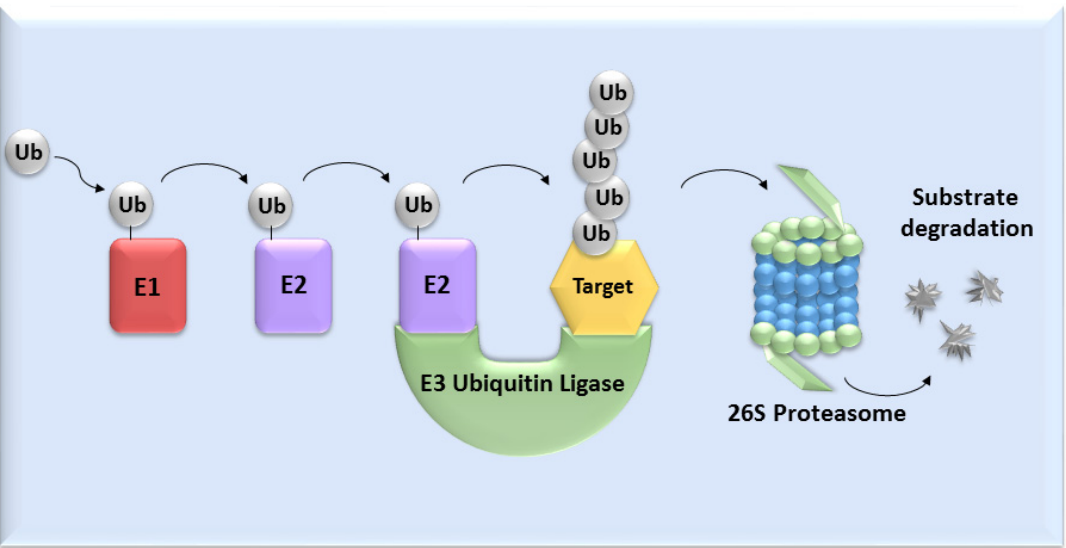
Figure 1. The ubiquitin-proteasome system. Activation and binding of ubiquitin to the target substrate is mediated by three enzymatic complexes (E1, E2 and E3 enzyme). The substrate is selected by E3 ubiquitin ligase and after tagging by ubiquitin, substrate undergoes degradation mediated by 26S proteasome.